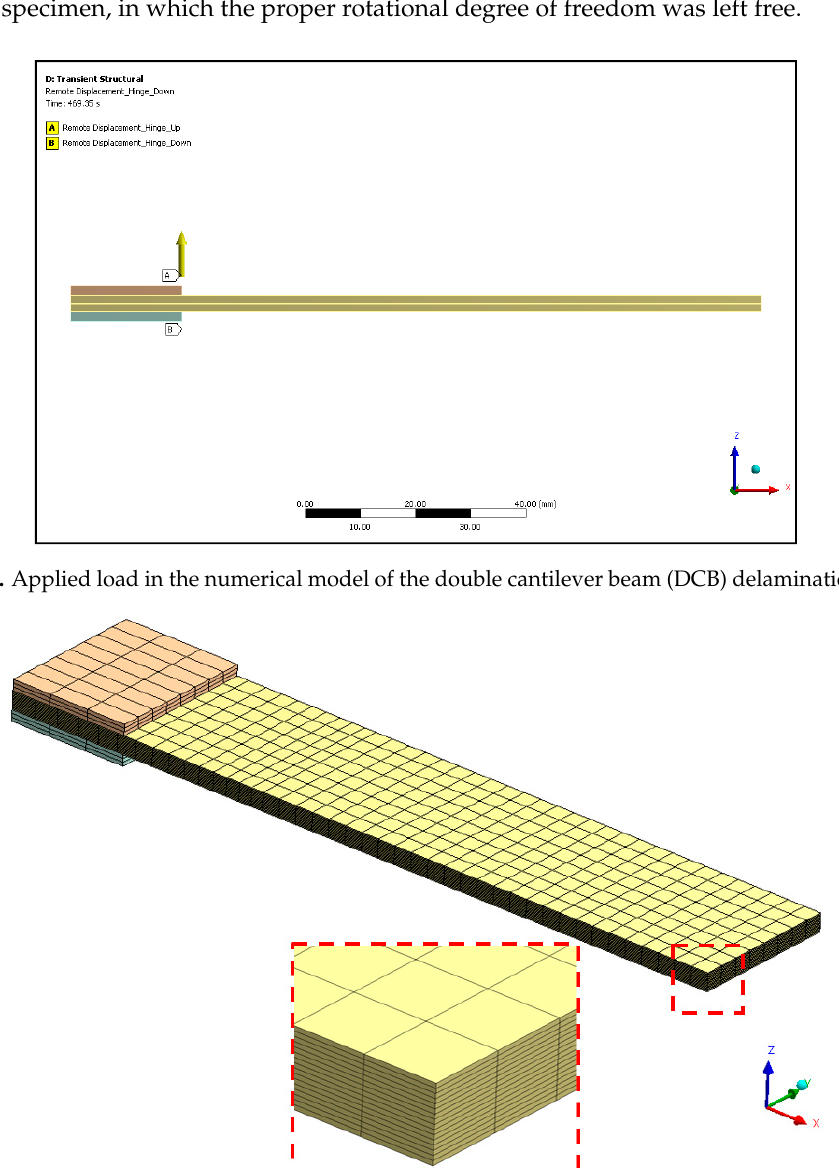
Figure 7 . Mesh sensitivity analysis: mesh sizes .